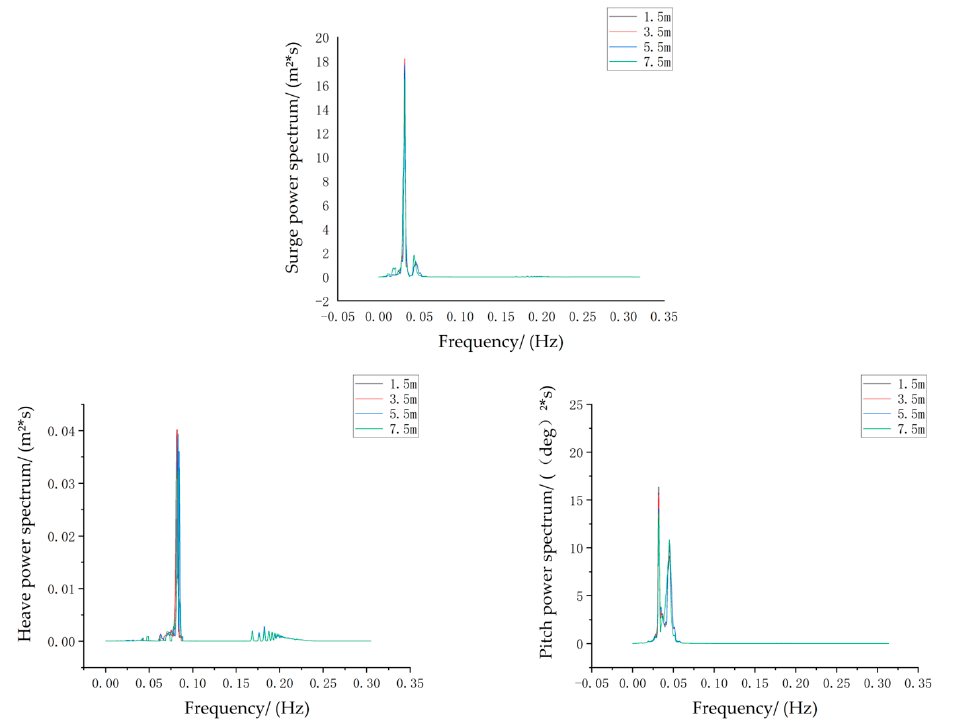
Figure 10. Frequency domain comparison of different auxiliary rope fairlead positions under normal operating conditions. Table 14. Motion RMS with different auxiliary rope fairlead positions under normal operating conditions.